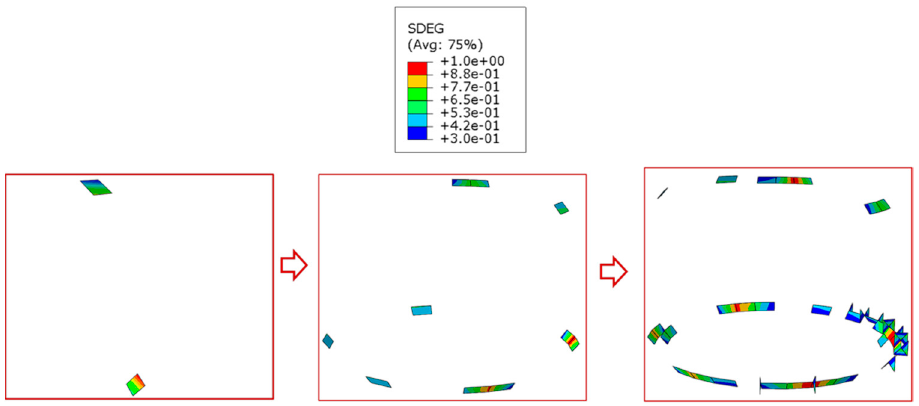
Figure 9. Fatigue damage progress of the CG specimen under 8936 N.